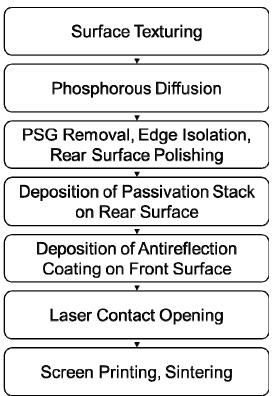
Figure 1. The manufacturing process flow of industrialized monocrystalline silicon solar cells.